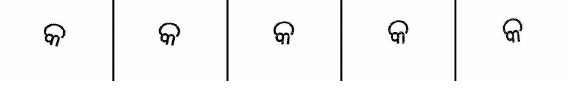
Figure 7. From left to right: Images rotated by 5 0 in anticlockwise direction in sequence.